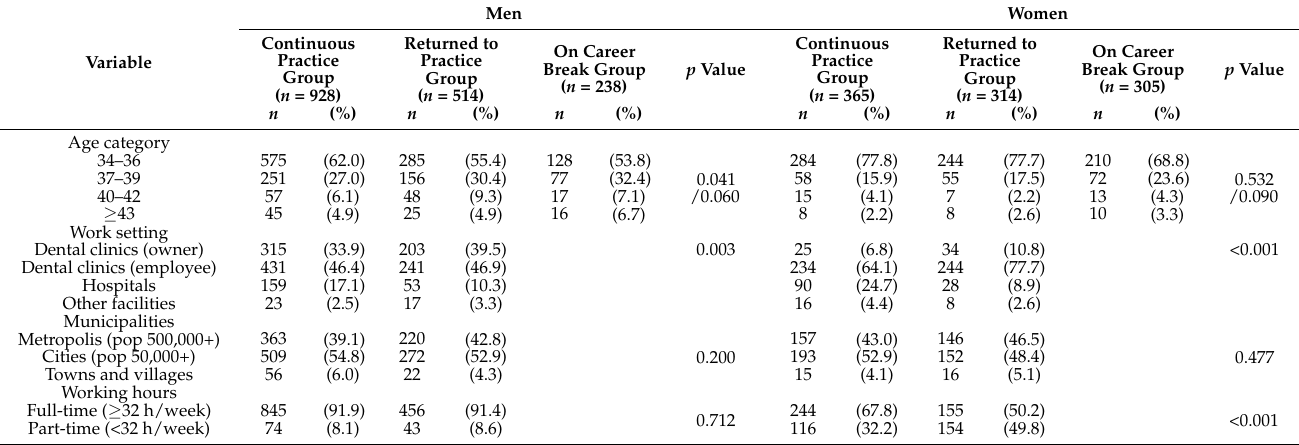
Table 2. Relationship between each group and the characteristics of the study participants. Men Variable